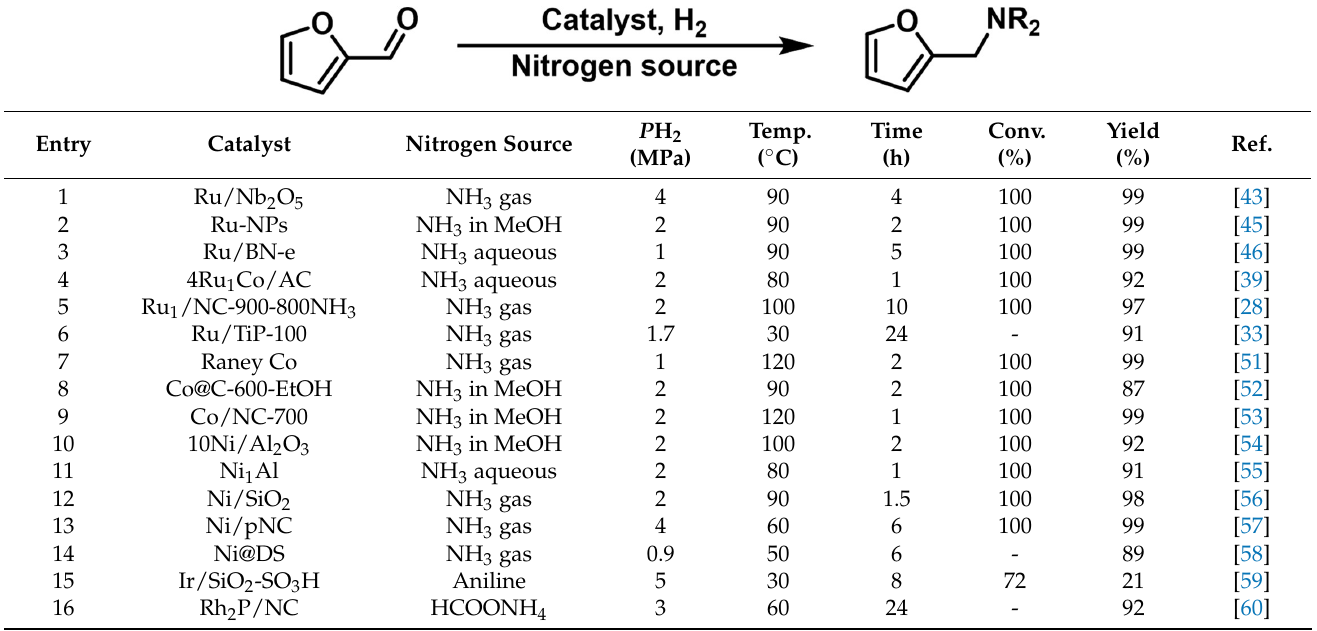
Table 1. Reductive amination of FF with different nitrogen sources.